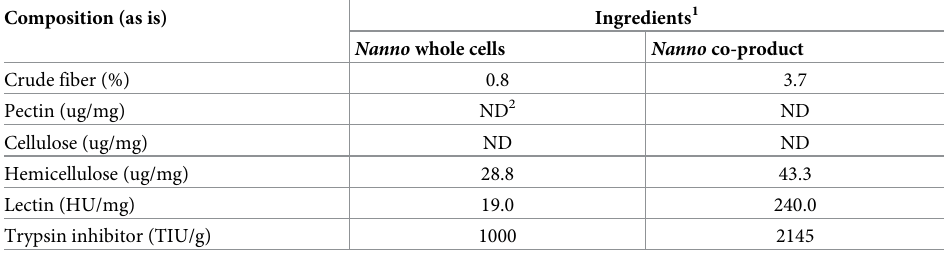
Table 4. Crude fiber, pectin, cellulose, hemicellulose, and trypsin inhibitor levels in the Nannochloropsisoculata whole cells and co-product. Composition (as